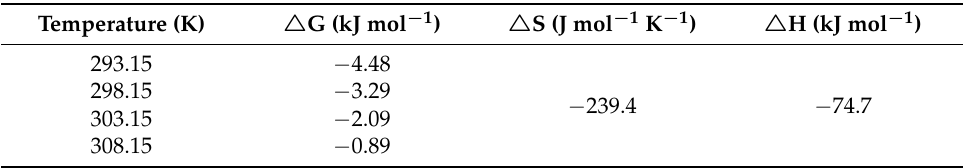
Table 5. Thermodynamic parameters for the absorption of Pd(CN) 42 − .